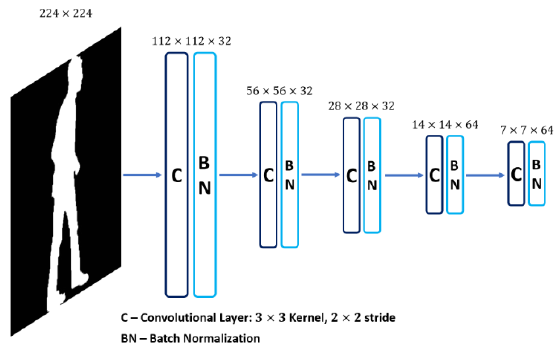
Figure 4. The proposed gait type classification CNN architecture.